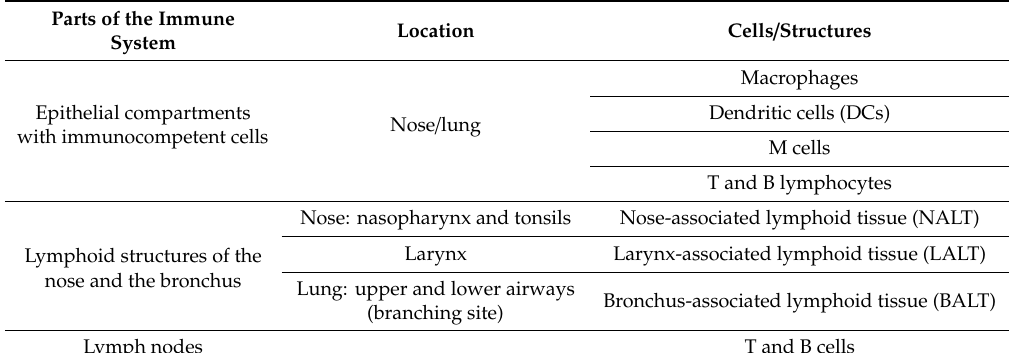
Table 2. Location of immune cells within the respiratory tract